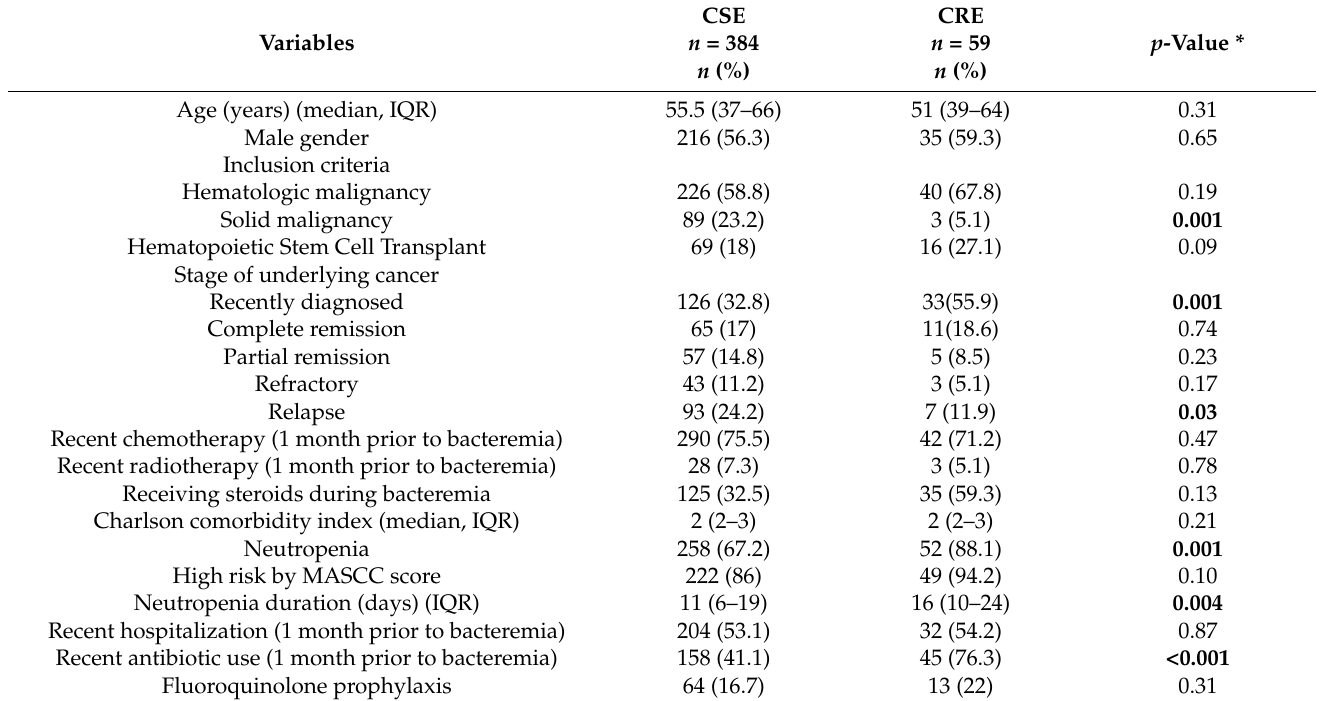
Table 1. Baseline characteristics of patients with carbapenem-susceptible Enterobacterales (CSE) and carbapenem-resistant Enterobacterales (CRE) bacteremia.